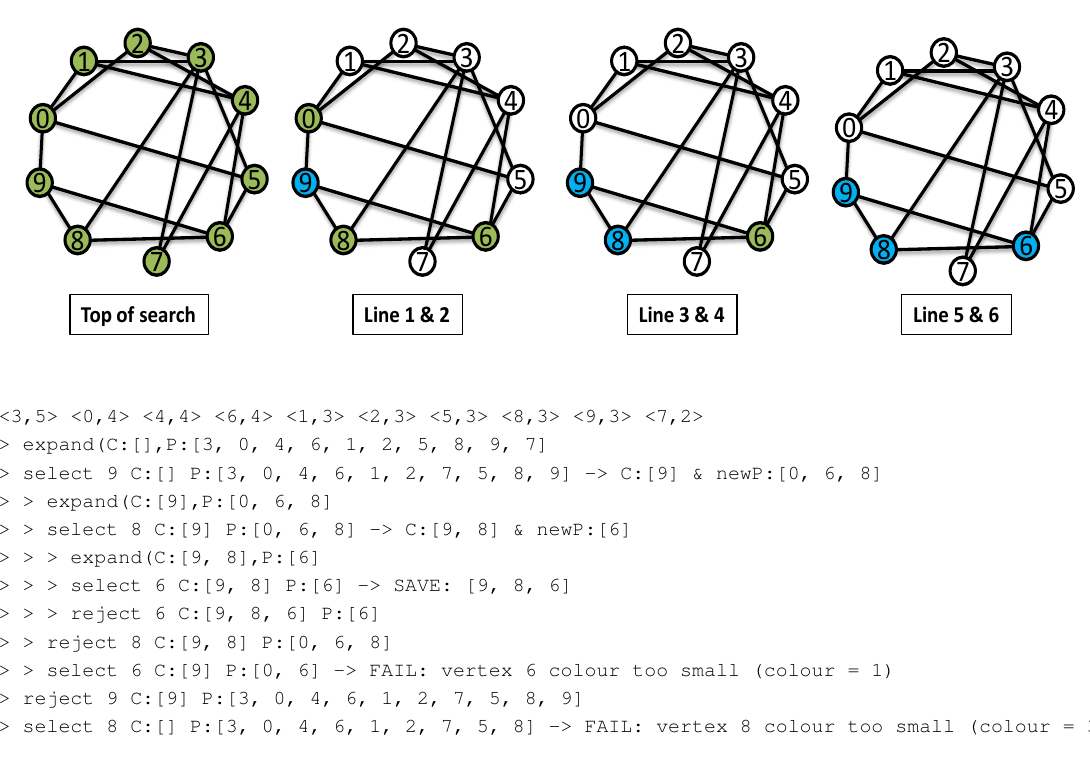
Figure 4. Trace of MCQ1 on graph